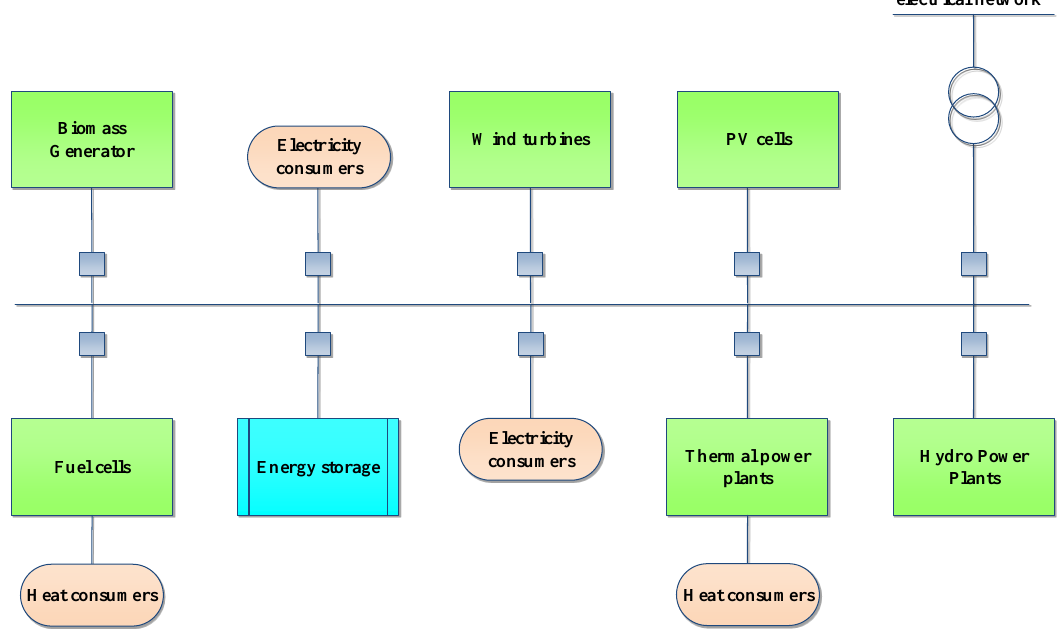
Figure 4. The basic structure of a hybrid microgrid.